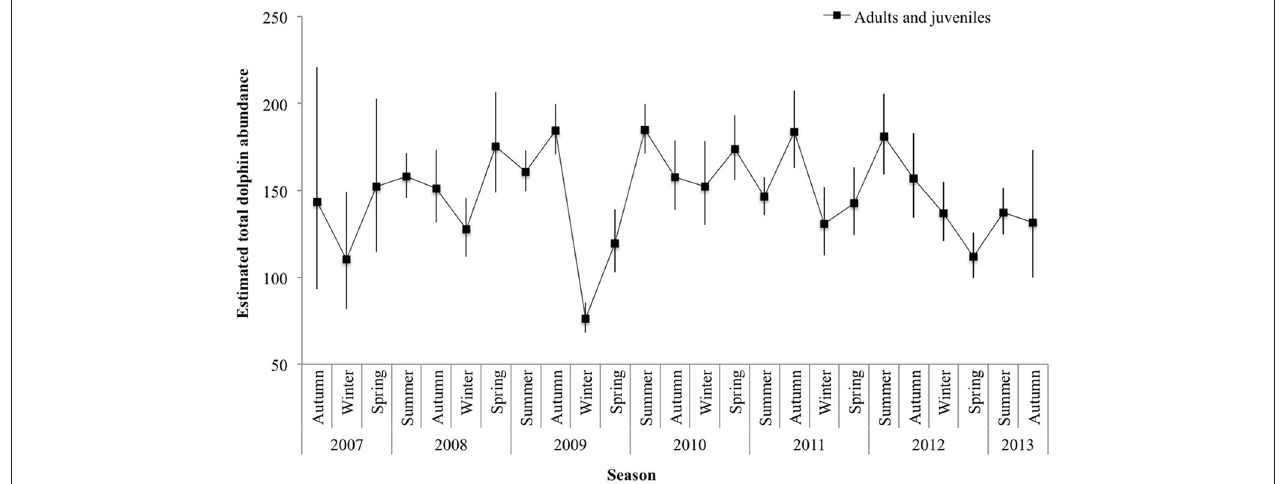
FIGURE 4 | Seasonal abundance estimates ( ˆ N total ) for adult and juvenile dolphins combined. Lines between data points of the seasonal mean have been used for illustrative purposes only; continuity of values is not implied. Vertical lines show 95% confidence intervals.